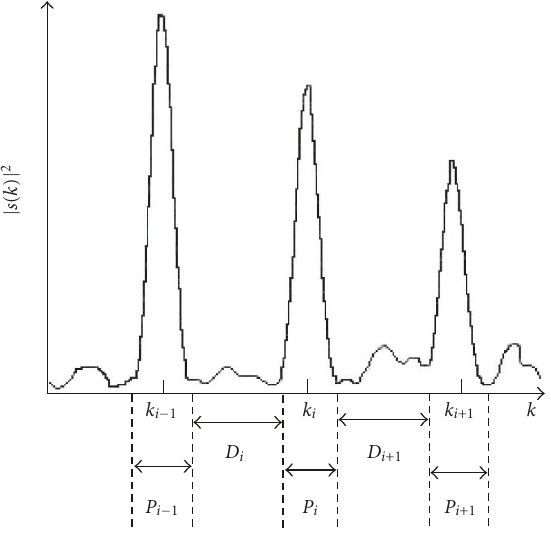
Figure 1: Schematic representation of the spectrum of a windowed voiced speech